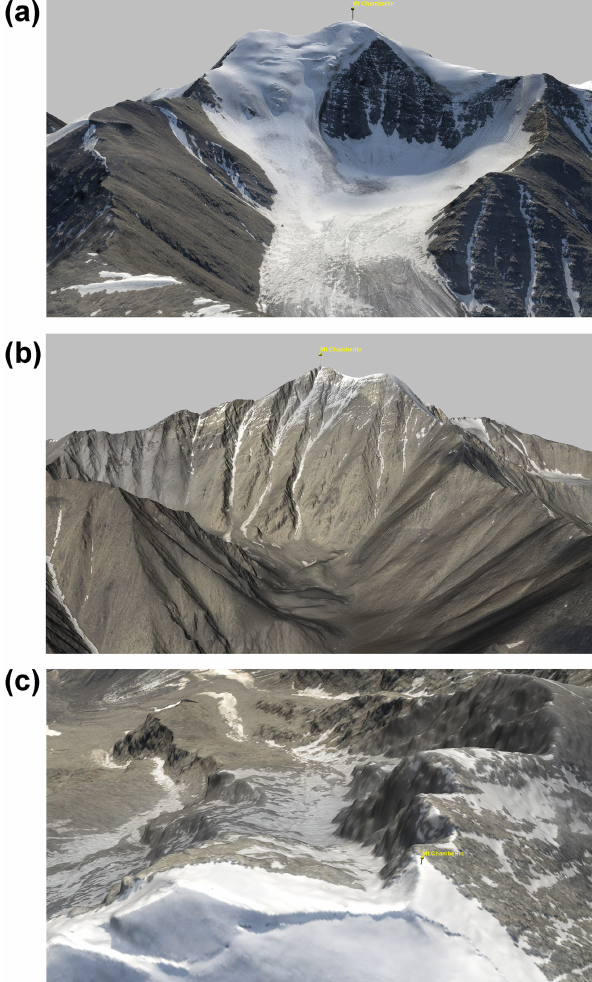
Figure 6. Evidence for recent ice and rock loss from Mt. Cham- berlin. (a) The northwest face shows massive, catastrophic loss of ice. (b) The southeast face is now completely free of ice, and rock debris piles have accumulated at its base. (c) Looking down from the peak to towards the southeast face reveals a curious notch in its shape, suggesting rock and ice avalanches may have occurred here in the past. The large map discrepancy along with these clues sug- gests that Mt. Chamberlin may have been the first or second tallest mountain in the US Arctic at one